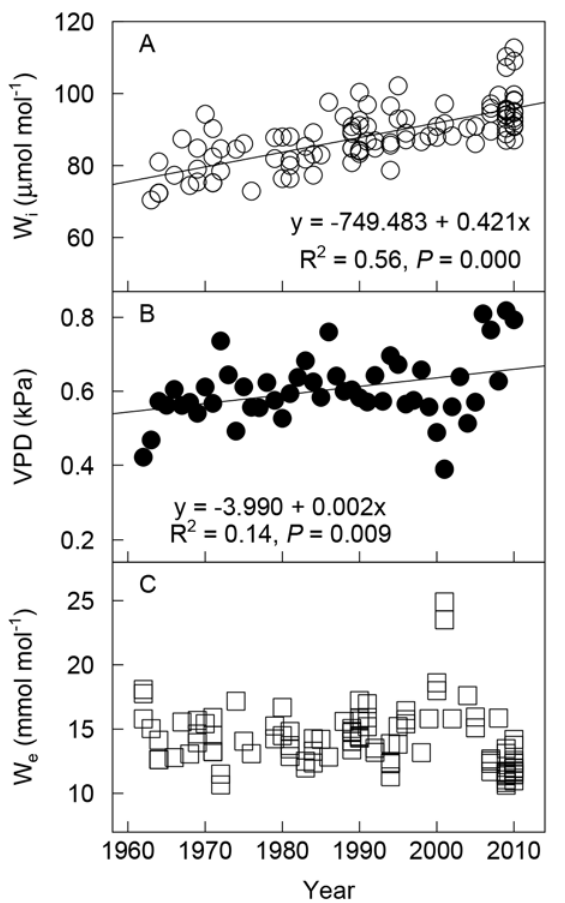
Fig 4. Ecophysiological parameters of Tibetan alpine meadows. (A) Intrinsic water use efficiency ( W i ), n = 106; (B) atmospheric vapor pressure deficit ( VPD ), n = 49; (C) effective water use efficiency ( W e ), n = 106. The parameter trend lines were calculated using values derived from δ 13 C of wool